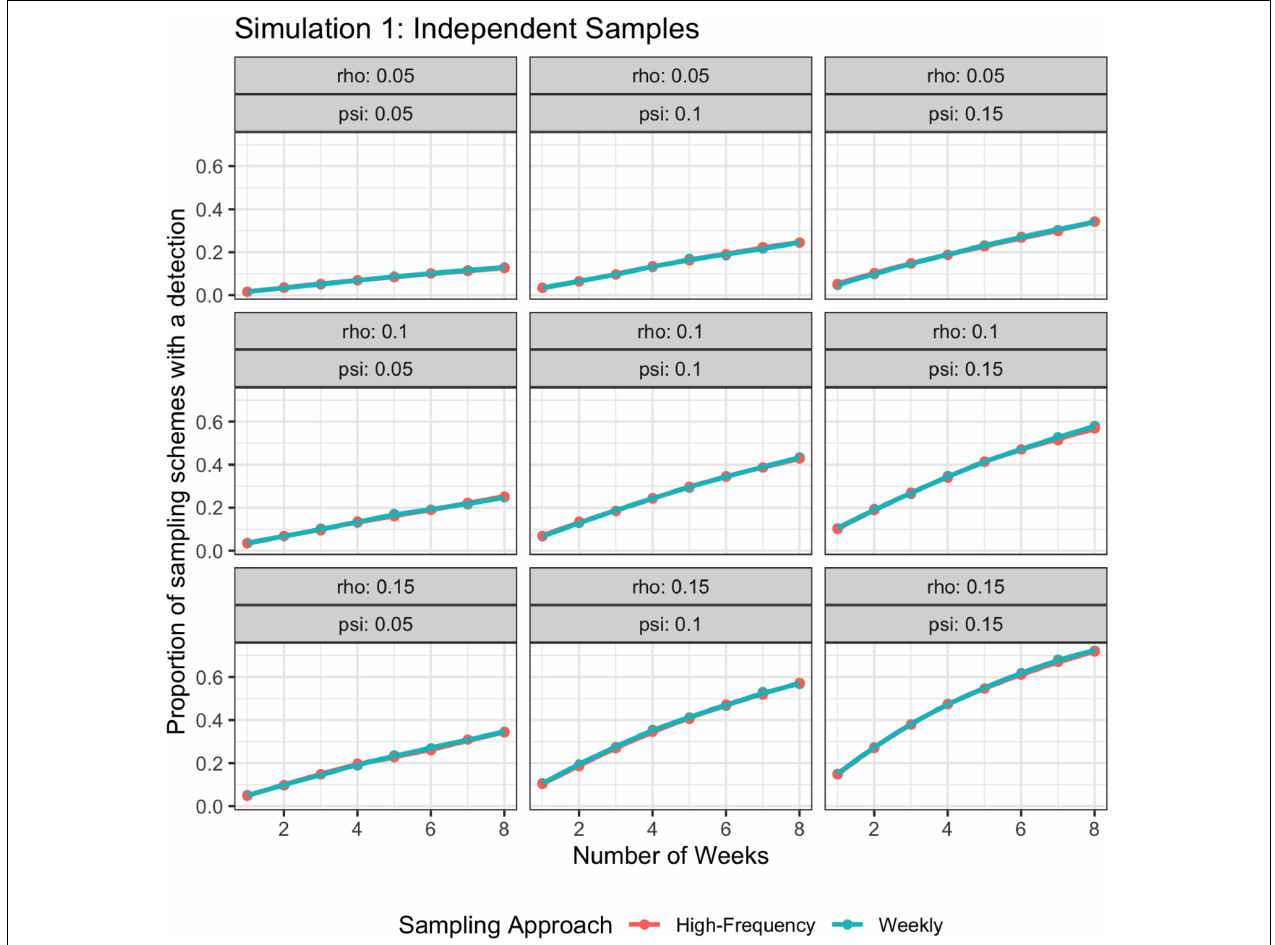
FIGURE 5 | Probability of detection as a function of rho , psi , and number of weeks; rho does not vary by time. The high-frequency approach collects samples daily and the weekly approach takes seven samples once a week. Weekly samples are modeled as independent samples.